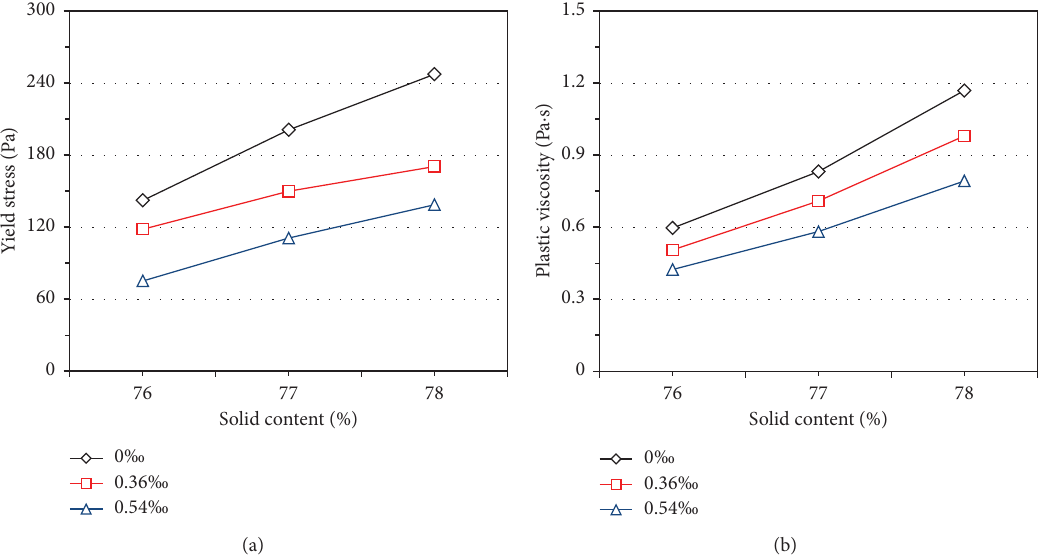
Figure 9: Effects of solid contents and PC dosages on the development of (a) yield stress and (b) plastic viscosity of